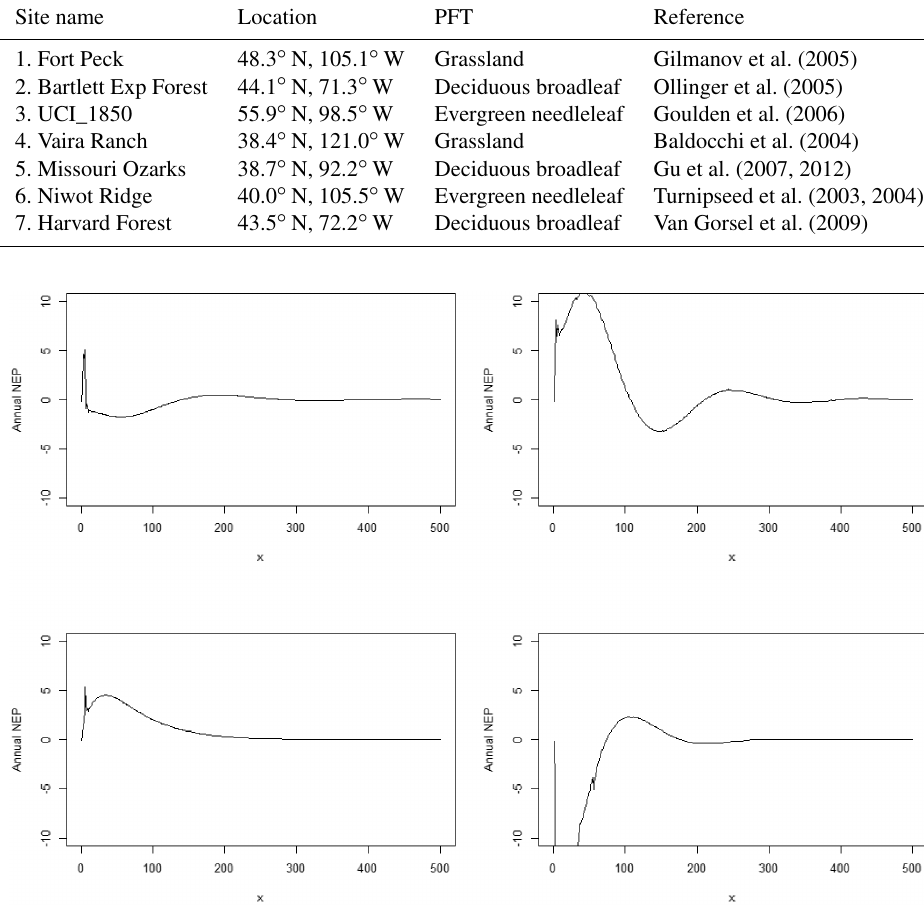
Figure 2. The time for NEP (gCyr − 1 m − 2 ) to reach a steady state with the original spin-up method at the Harvard Forest site. x represents model simulation